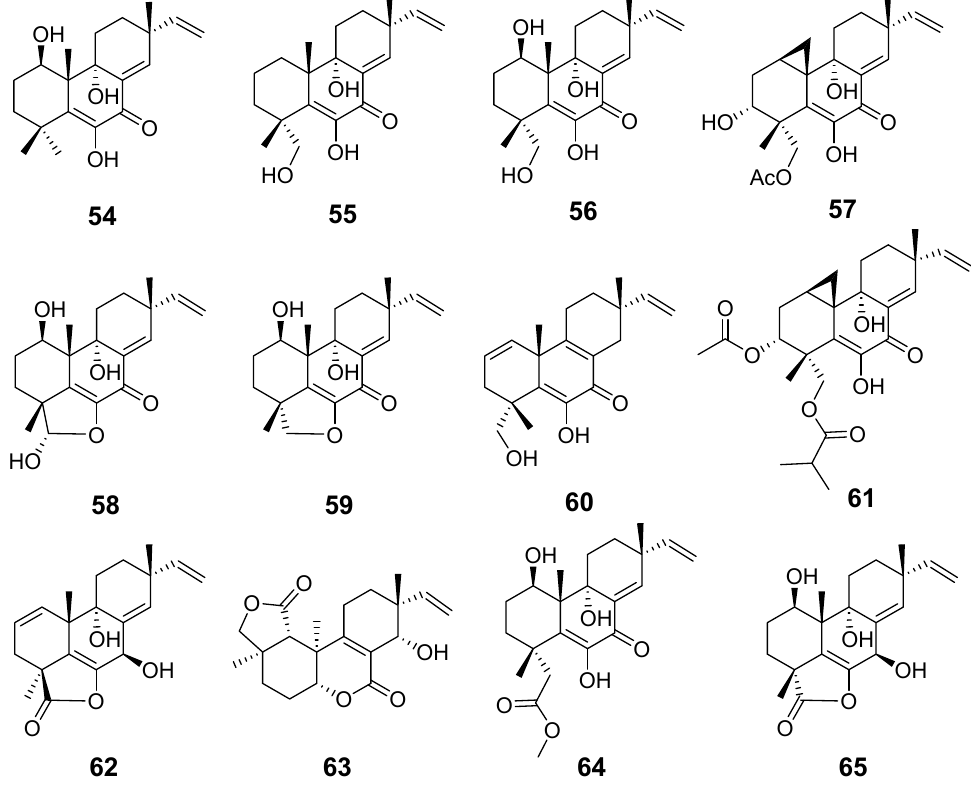
Figure 5. Structures of compounds 54 – 65 . Libertellenone M ( 66 ) and N ( 67 ) (Figure 6) were isolated from Eutypella sp. Compound 67 displayed cytotoxicity against K562 cells, with an IC 50 value of 7.67 µ M, and moderate cytotoxic activities against HeLa, MCF-7, and SW1990 cell lines [32]. By a discovery approach based on a combination of bioassay-guided and dereplication, the compound 68 (Figure 6), also called libertellenone M, was obtained from Stilbella fimetaria . It showed cytotoxicity against patient-derived glioblastoma stem-like cells, with IC 50 values of 18 μ M, and weak cytotoxicity against several other cancer cell lines [33]. their cytotoxic activities against HeLa, MCF-7, HCT-116, PANC-1, and SW1990 cell